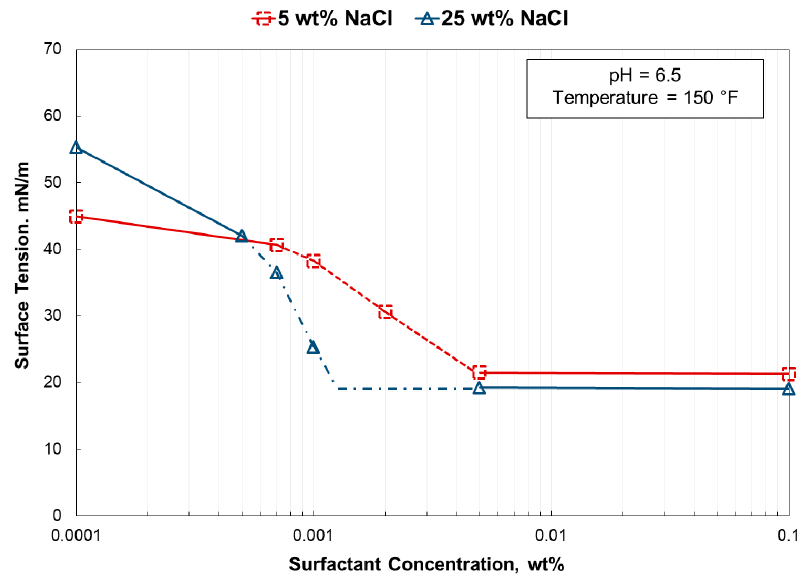
Figure 16. Role of NaCl concentration on the surfactant solution interfacial properties at pH 6.5 and 150 °F (65 °C).